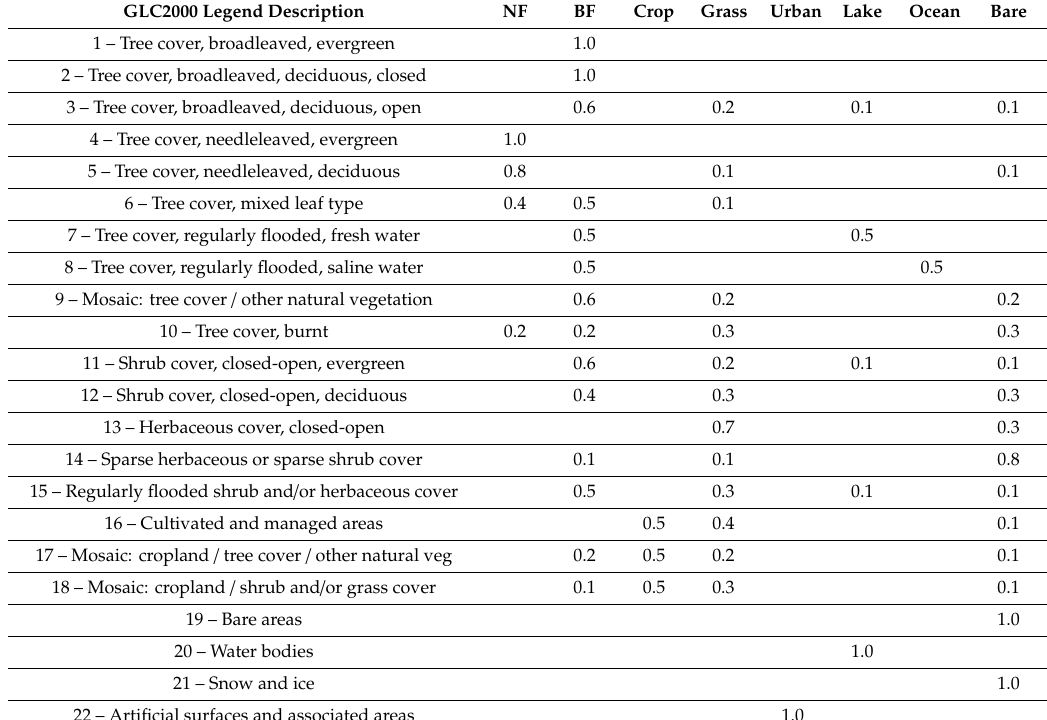
Table 5. Cross-walking table for converting GLC2000 LC classes into CLASS PFTs. GLC2000 Legend Description NF BF